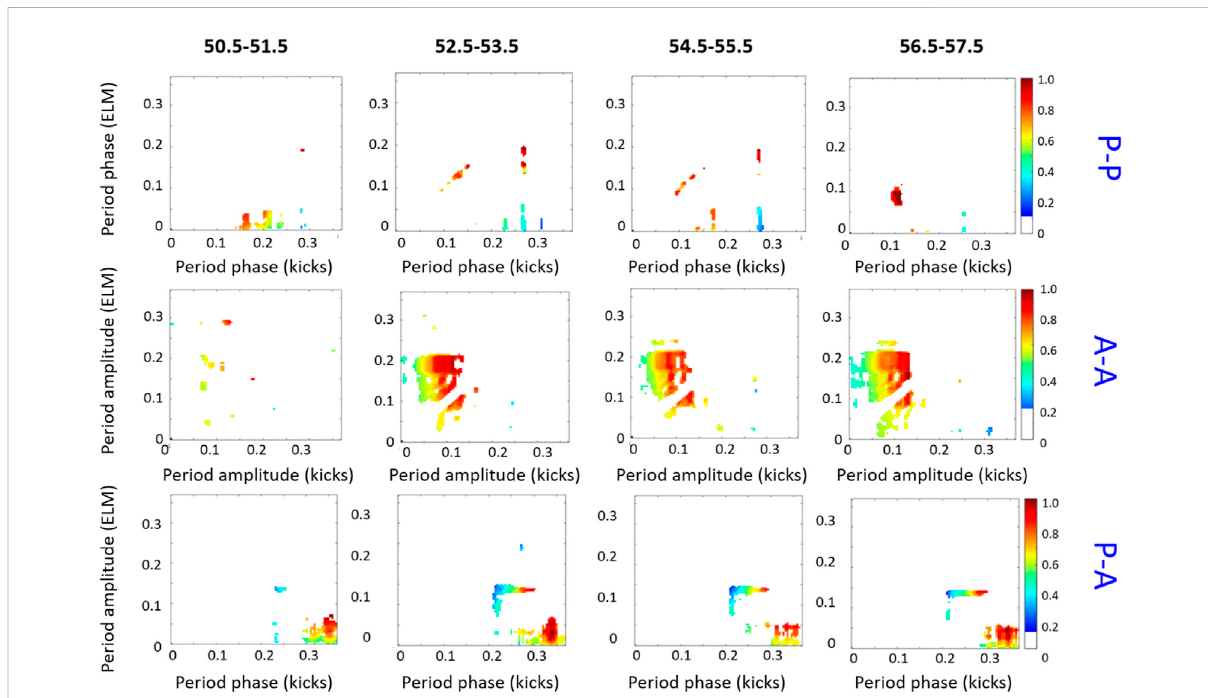
FIGURE 6 ValuesofCMIfortheexperimentofELMpacingwithverticalkicks,whosemaincharacteristicsareshowngraphicallyinFigure5.Theaxesreport the various types of interaction (amplitude-amplitude, phase-amplitude etc. ). The colour code represents the level of coupling derived with the conditional mutual information CMI. The CMI plots corresponding to phase-phase (P-P, fi rst row), amplitude-amplitude (A-A, second row) and phase-amplitude(P-A,thirdrow)areshownforfourtimeintervals,fromlefttorightcolumn[50.5 – 51.5]s,[52.5 – 53.5]s[54.5 – 55.5]s,[56.5 – 57.5] s. CMI plots are shown with the period of the driver time series (kicks evolution) on the x -axis and driven time series (ELMs) on the y -axis. Periods are measured in seconds. Shown are the positive signi fi cance-level deviations from the 99th percentile of the average CMI calculated using 50 Fourier transform